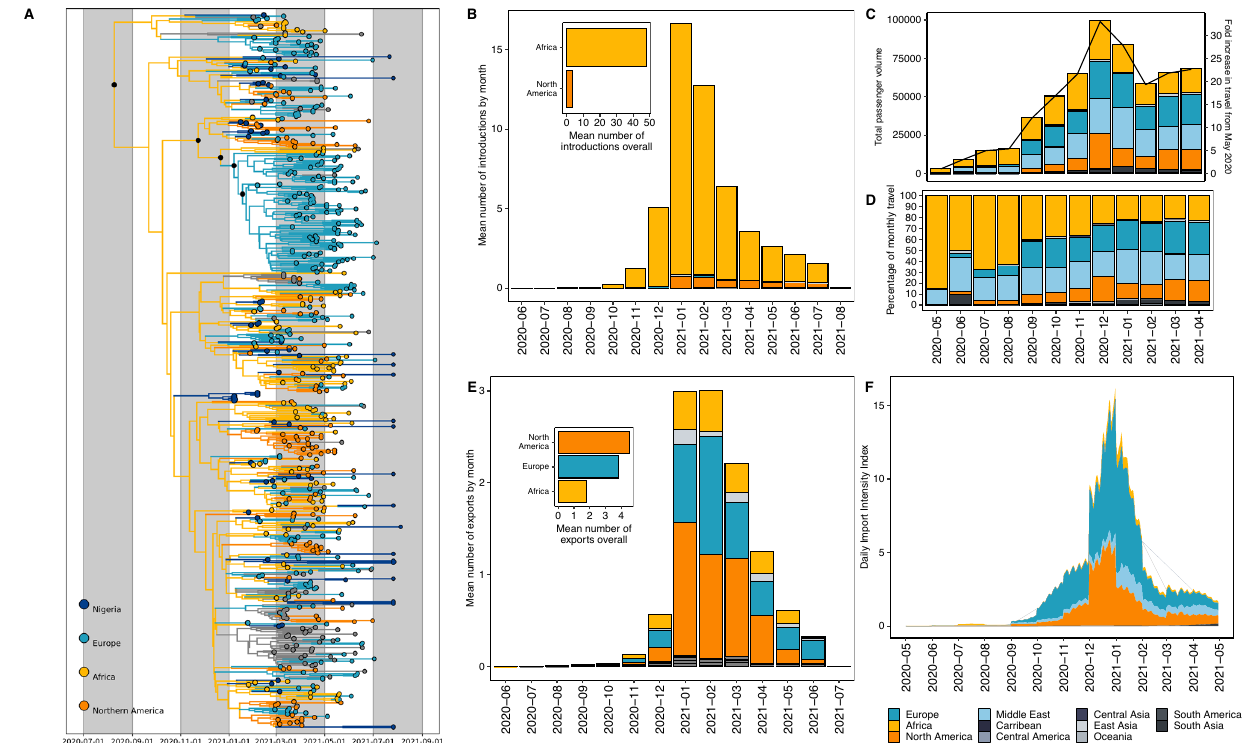
Fig. 2 | Bayesian phylogeographic reconstruction of the B.1.1.318 variant. A Time-resolved B.1.1.318 phylogeny. Branches are coloured by region-level geo- graphic state reconstruction. Locations with negligible contributions have been grouped and annotated in grey. Internal nodes annotated with black points represent posterior support > 0.75. B Mean number of introductions (Markov jumps)ofB1.1.318intoNigeriafromallsourceregions,binnedbymonth.Themean number of introductions overall (inset). C Volume of monthly air passengers